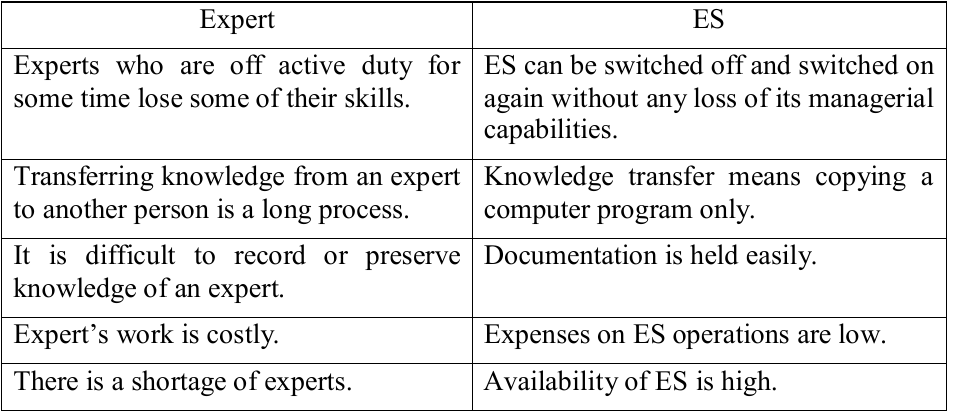
Table 1 – Advantages of process management based on ES Expert